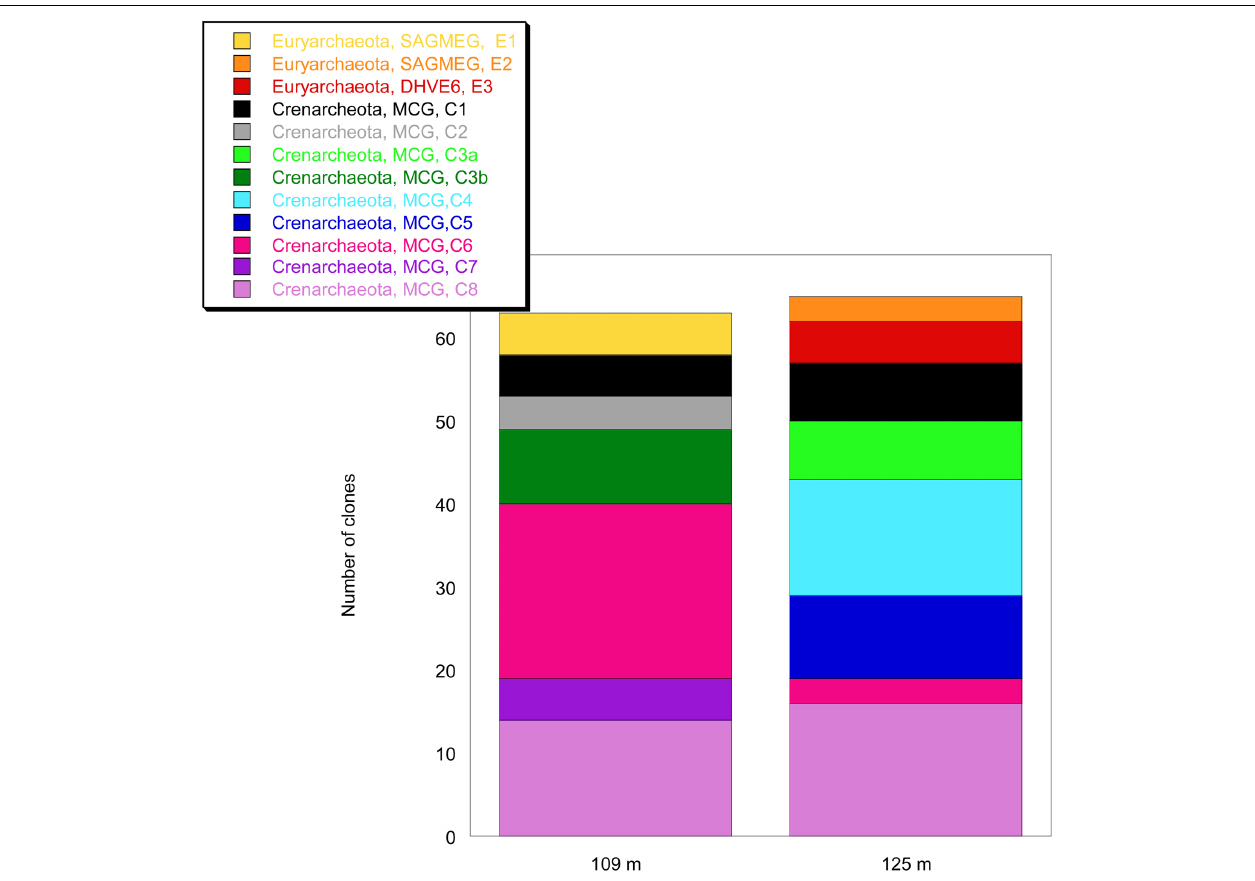
FIGURE 5 |Analysis of the composition of the archaeal community in the terrestrial CBIS post-impact sediment at 109 and 125m depth.